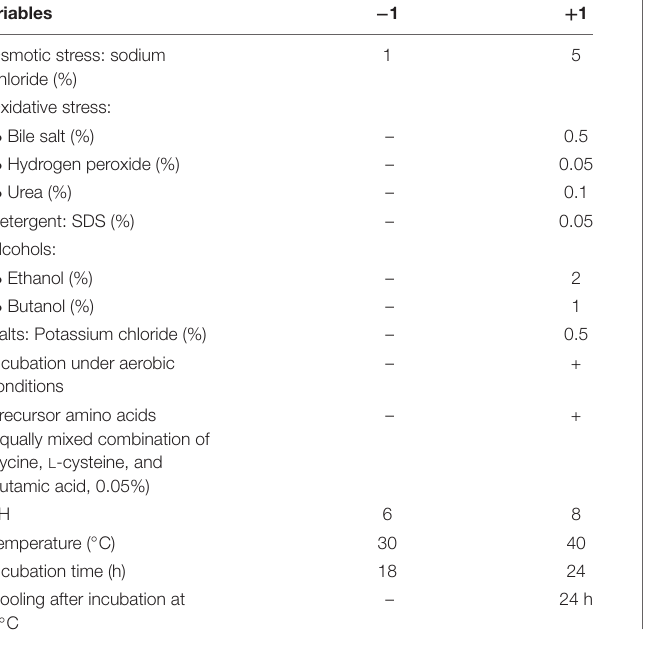
TABLE 1 | Variables and levels used in Plackett–Burman design for screening of culture conditions affecting glutathione (GSH) production. Variables −